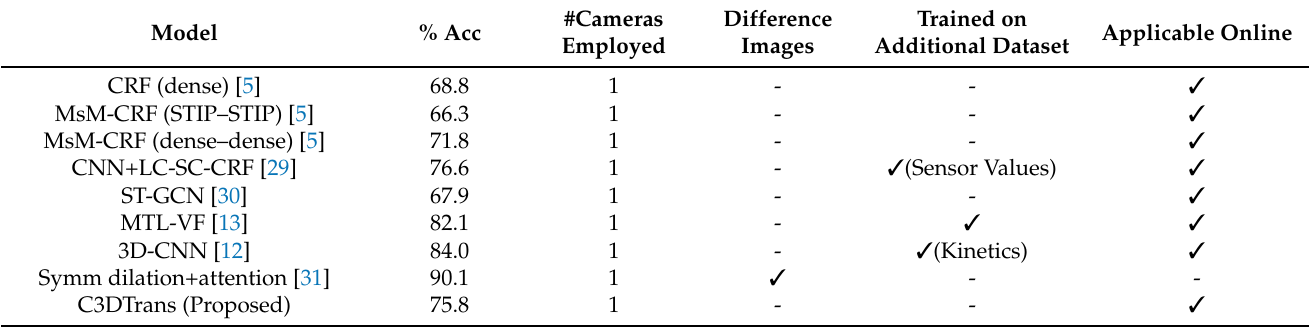
Table 8. Accuracy comparison for surgical gesture recognition on the SU task of JIGSAWS. The table also illustrates some key features of the